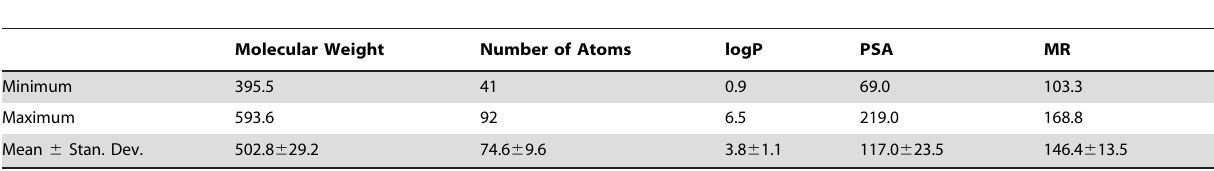
Table 2. To demonstrate the diversity of the compounds generated, fifty azides and fifty alkynes were selected at random and reacted in silico using